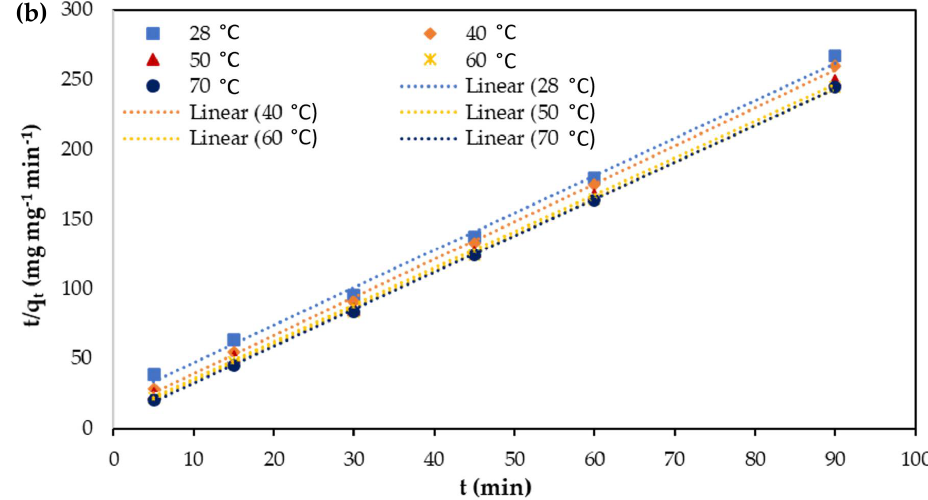
Figure 12. Adsorption kinetics s modeling for the removal of Cu(II) and Cr(VI) from aqueous solution using M-OPEFB-CNF as a bio-sorbent. ( a ) Pseudo-first-order kinetic model and ( b ) pseudo-second- order kinetic model.